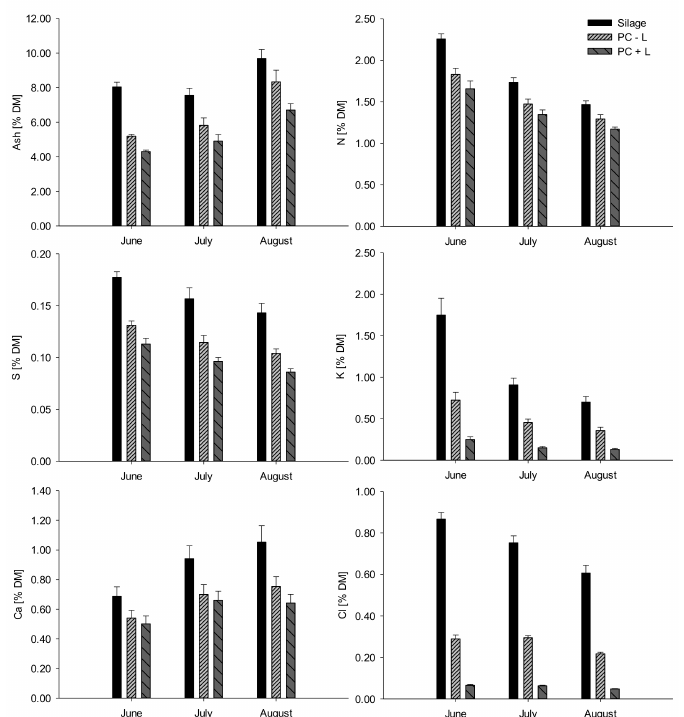
Figure 1. Experiment 1: Mean concentrations of ash, N, S, K, Ca and Cl in silage and press cake (PC), with (PC+L) and without (PC-L) leaching step (L) at different sampling dates (June = 17 June 2013, July = 15 July 2013, August = 13 August 2013). Error bars show the standard errors of the means. DM: dry